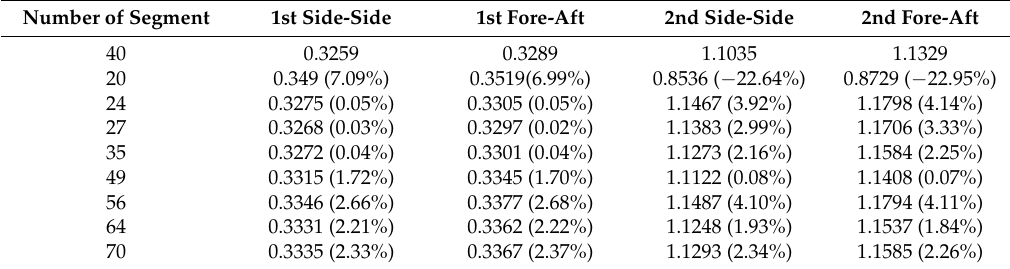
Table 5. Modal Analysis for NREL 5 MW WTG FAST Model and OC4 Jacket Substructure Model.